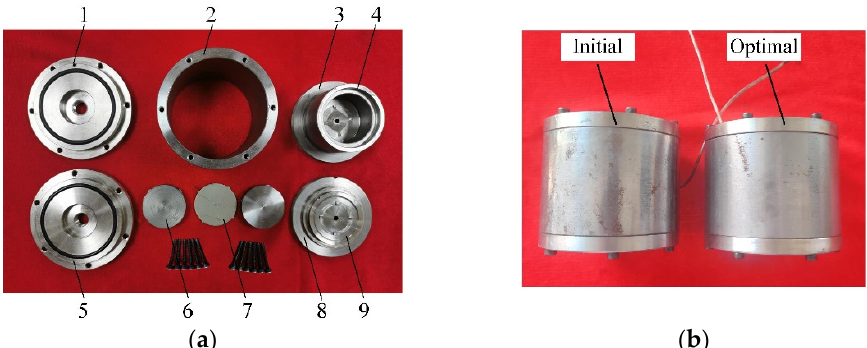
( b ) Figure 13. Comparison of the initial and optimal performance indicators: ( a ) pressure drop Δ p , ( b ) power consumption P w. 5. Performance Analysis of the Enhanced Radial MR Valve 5.1. Prototype and Experimental Test Rig Setup According to the structural parameters of the initial and optimal MR valve in Tables 1 and 4, the prototype of the enhanced radial MR valve as shown in Figure 14 was manu- factured, and the performance test rig was also built up that was shown schematically in Figure 15. The motor drives the gear pump to work, which could deliver the MR fluid to the MR valve. The pressure sensor (a) and (b) were adopted to measure the inlet and outlet pressure of the MR valve, respectively. The relief valve (A) acts as a safety valve to protect